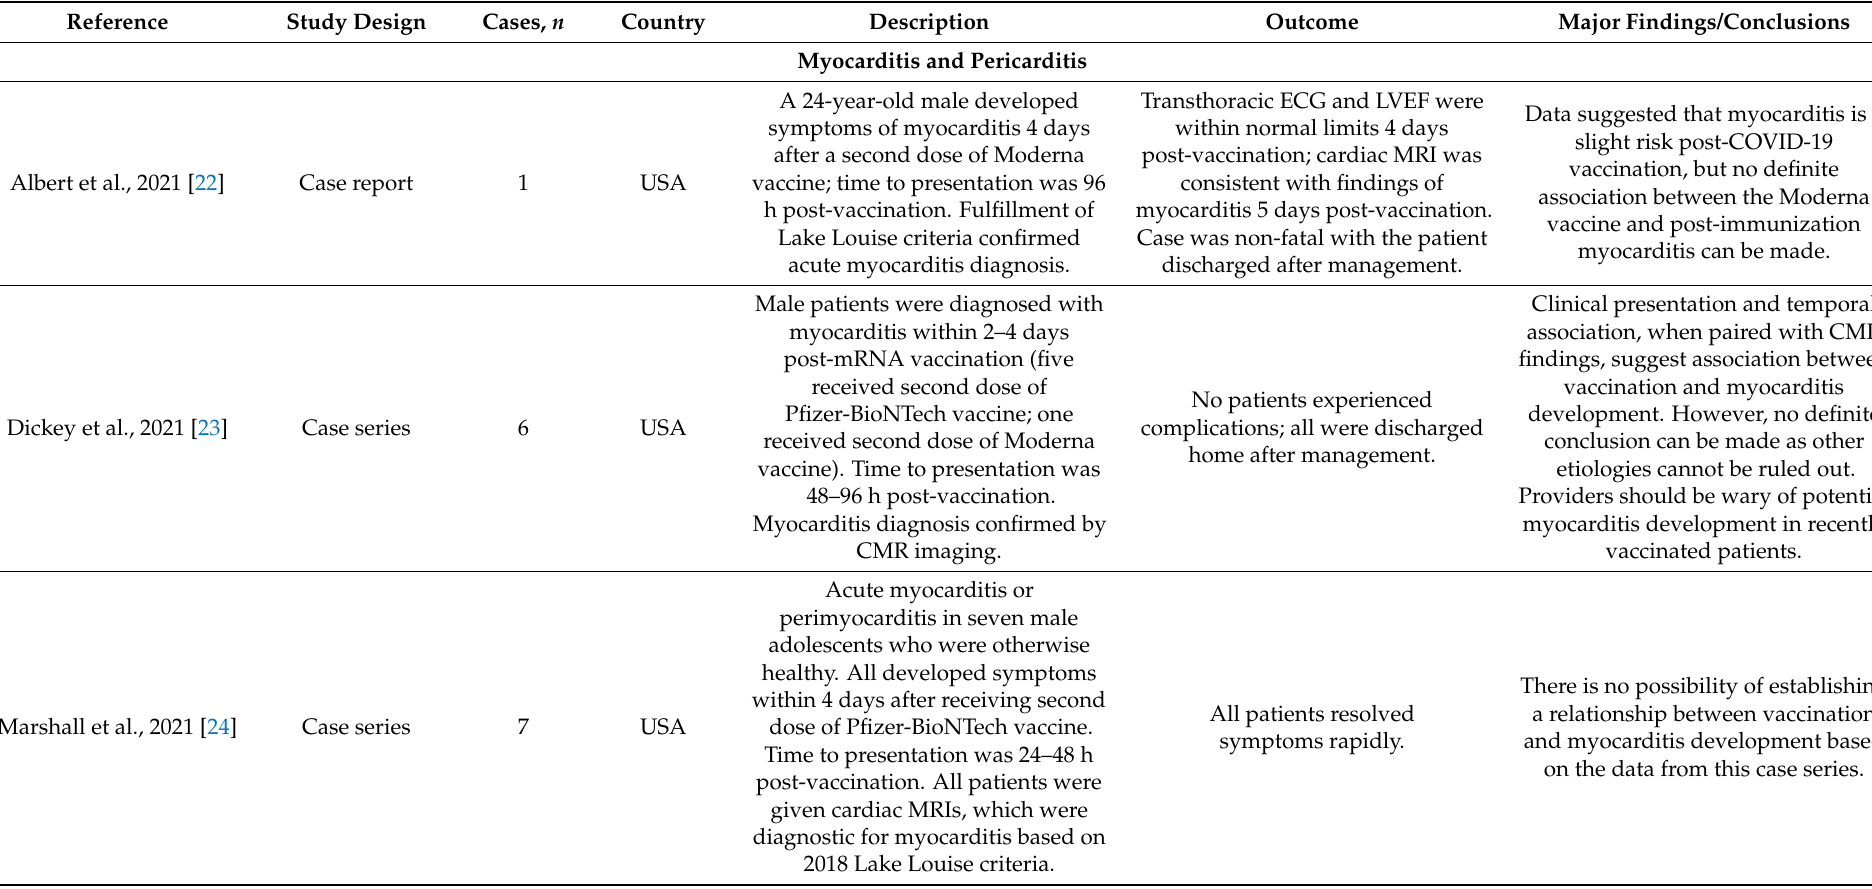
Table 1. Summary of included studies of adverse events following mRNA COVID-19